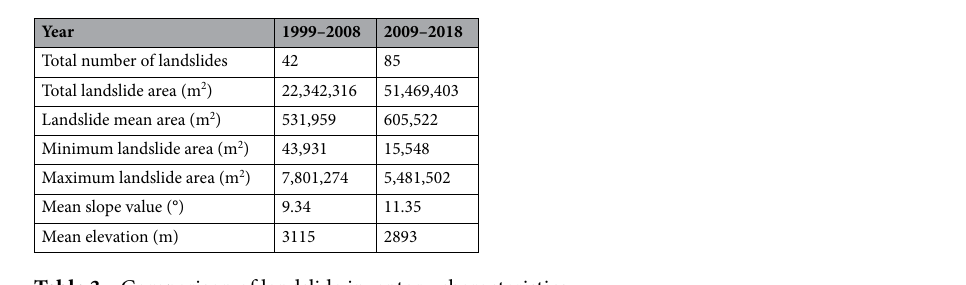
Table 3. Comparison of landslide inventory